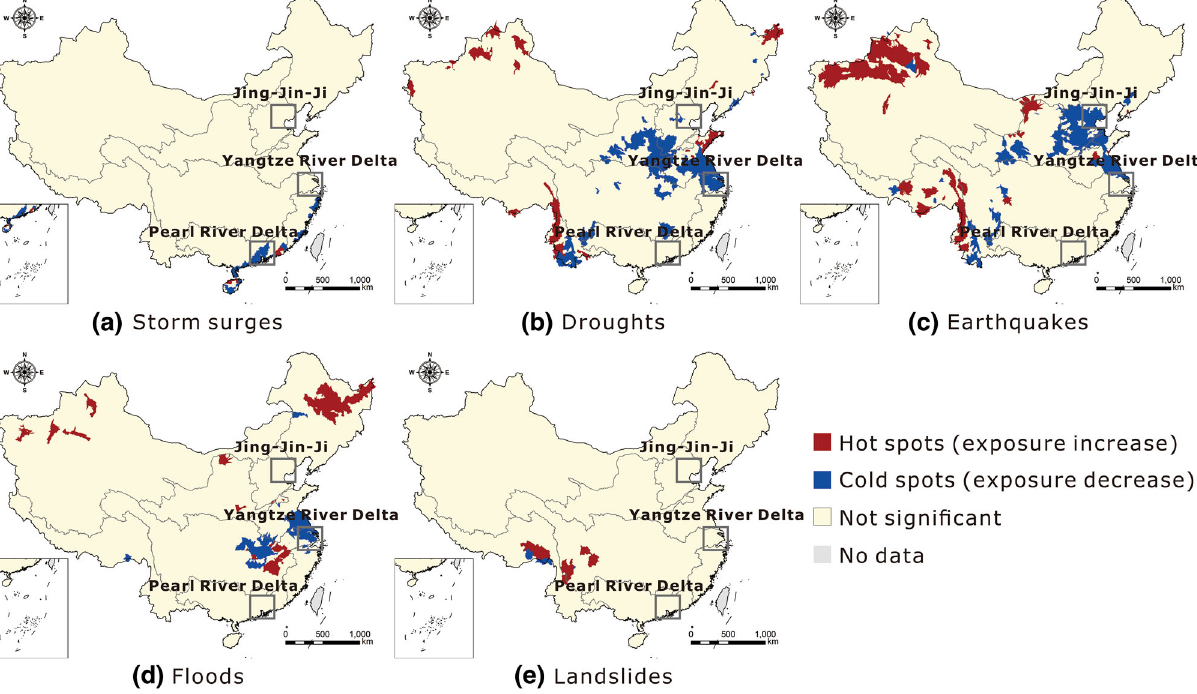
Fig. 8 Hot/cold spots of changes in cropland exposure to hazards in China from 2005 to 2015. Jing-Jin-Ji: Beijing–Tianjin–Hebei